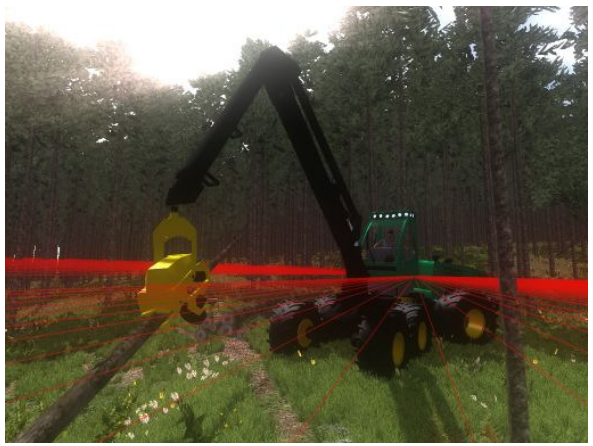
Figure 10 A Virtual Testbed with a harvester using door- mounted laser scanners to generate a local tree map These are only five examples of applications that benefit from the innovative database-driven, high detailed forest